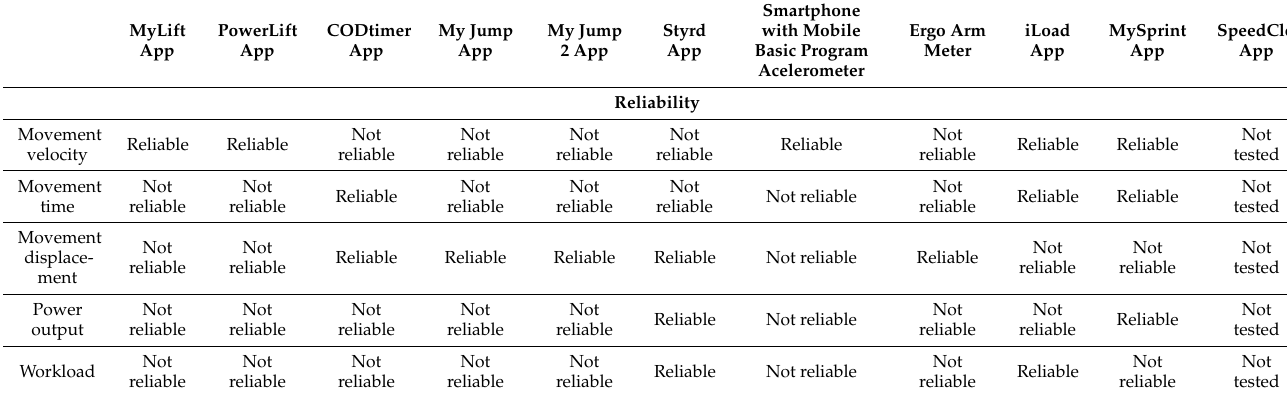
Table 7. Summary of reliability of different